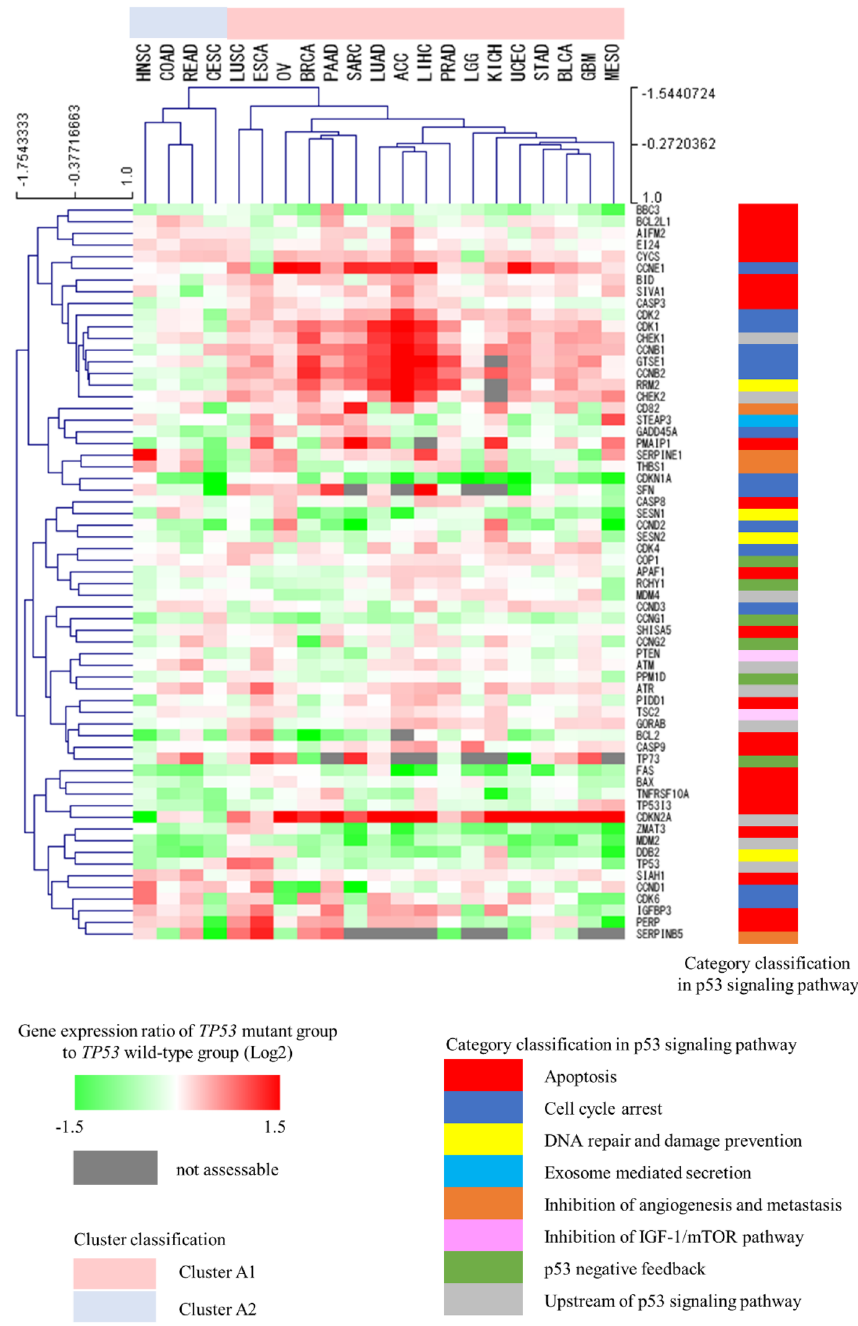
Figure 2. Unsupervised cross-cancer hierarchical clustering. This cluster analysis was performed using the complete linkage method with Pearson correlation distance. ACC Adrenocortical carcinoma, BLCA Bladder urothelial carcinoma, BRCA Breast invasive carcinoma, CESC Cervical squamous cell carcinoma, COAD Colon adenocarcinoma, ESCA Esophageal carcinoma, GBM Glioblastoma multiforme, HNSC Head and neck squamous cell carcinoma, KICH Kidney chromophobe, LGG Brain lower grade glioma, LIHC Liver hepatocellular carcinoma, LUAD Lung adenocarcinoma, LUSC Lung squamous cell carcinoma, MESO Mesothelioma, OV Ovarian serous cystadenocarcinoma, PAAD Pancreatic adenocarcinoma, PRAD Prostate adenocarcinoma, READ Rectum adenocarcinoma, SARC Sarcoma, STAD Stomach adenocarcinoma, UCEC Uterine corpus endometrial